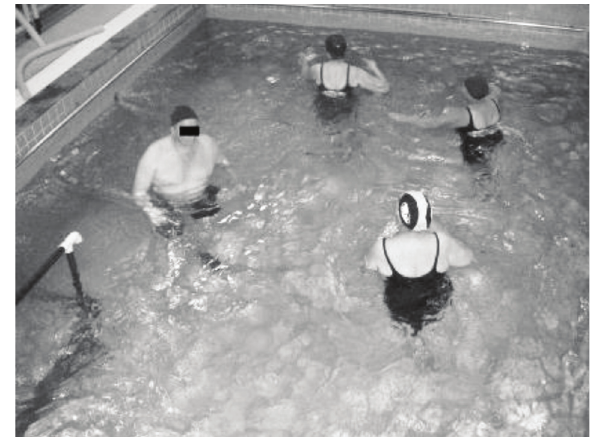
Figura 3 - Demonstração de exercícios de cadeia muscular lateral na FA Fonte: Dados da pesquisa.